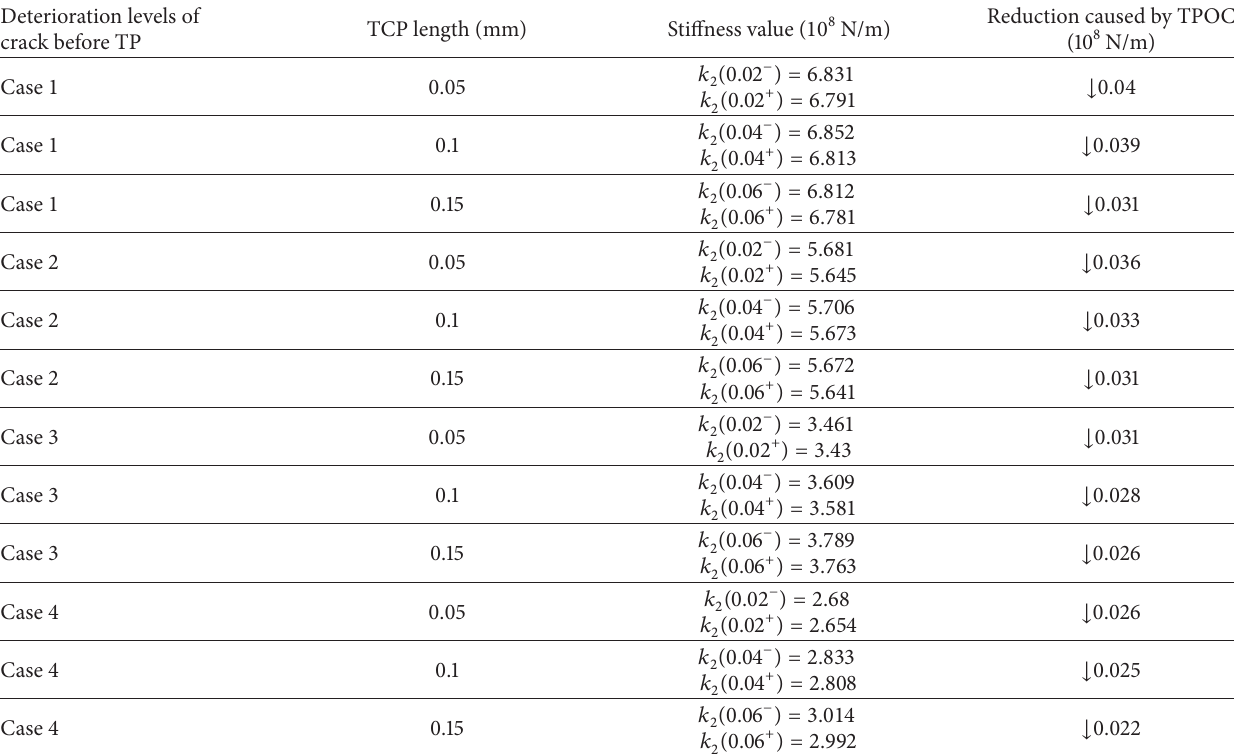
Table 5: Mesh stiffness reduction caused by TPOC with the model of a continuous step function in different deterioration levels. Deterioration levels